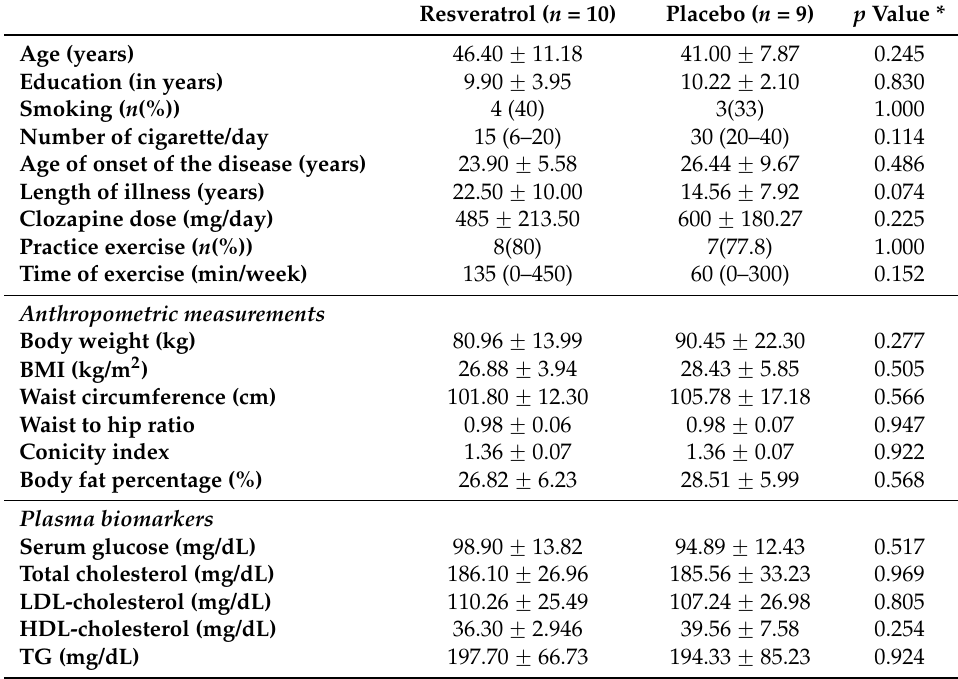
Table 1. Baseline clinical parameters of patients in the resveratrol and placebo